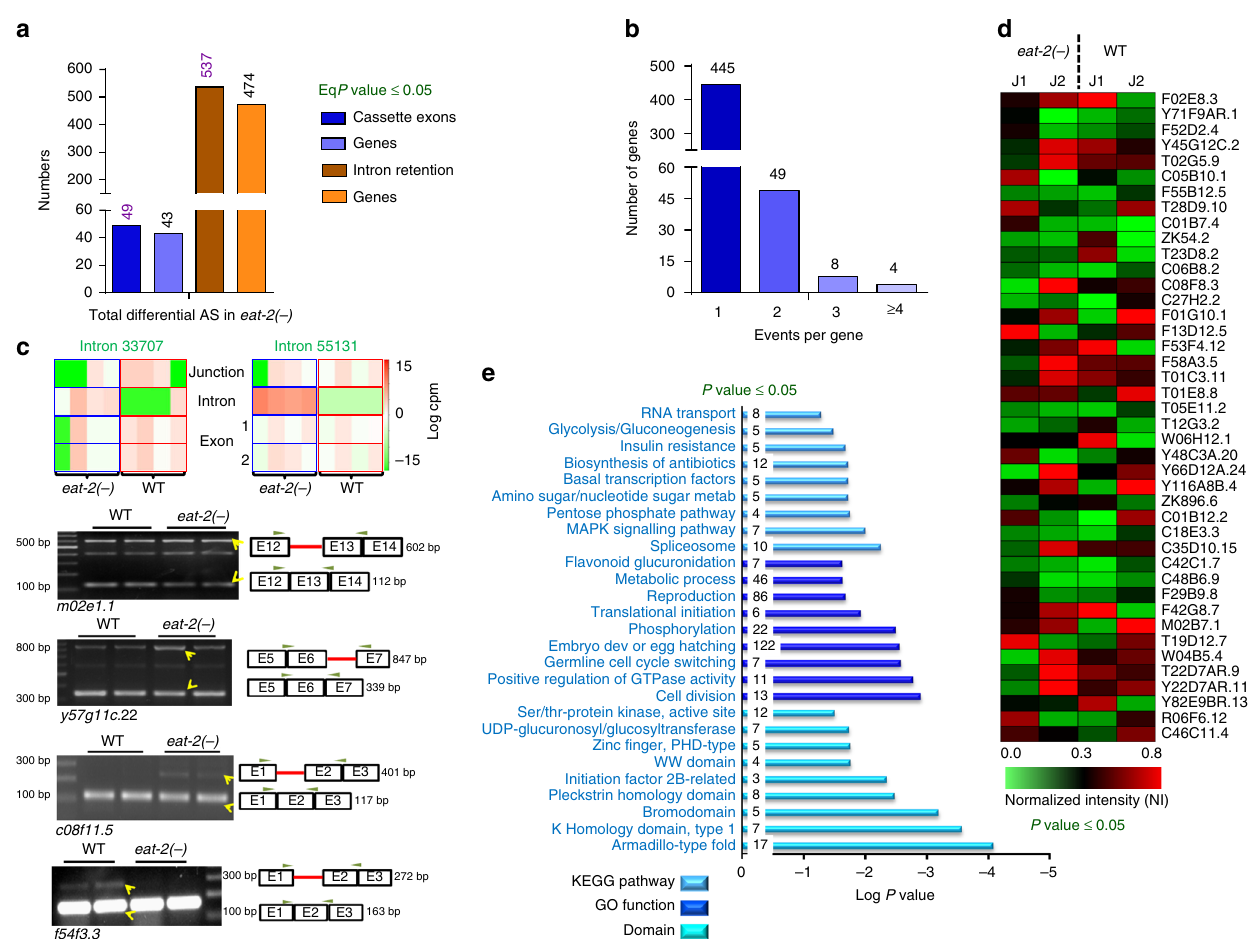
Fig. 1 Increased alternative splicing during DR in C. elegans . a AS events in day 3 eat-2(ad1116) (shown as eat-2(-) ) worms, as exhibited by the differential usage of cassette exons (CE; dark blue bars ) or by intron retention (IR; dark brown bars ). Total spliced-in and spliced-out events in eat-2(ad1116) are shown. The genes that these events correspond to are indicated in the lighter shades . Statistical test: Irwin – Hall P value summarization was used on each individual splicing event (details in the Methods section). Four biological replicates were used for analysis. b Distribution of the number of AS events per gene during DR. Both CE and IR events are considered together. c Upper panels showing representative images of AS involving intron retention. For this, two terms were considered, reads mapping to the introns and that of the skipping junction when the intron is not included, while ensuring that fl anking exons are expressed. Each blue or red box represents four biological replicates of the RNA-seq. In case of Introns 33707 and 55131, the read counts mapping to the intron or the junction were reciprocal in eat-2(ad1116) vs. WT. Lower panels : The above intron retention events belonging to m02e1.1 and y57g11c.22 are validated by RT-PCR. Two other AS events belonging to c08f11.5 and f54f3.3 are also validated below. In case of m02e1.1 , y57g11c.22 and c08f11.5 , the isoforms retaining the intron increase in eat-2(ad1116) , whereas the reverse happens in f54f3.3 . The two lanes for each sample are biological replicates. Yellow arrows indicate two alternatively spliced isoforms that show differential expression in WT and eat-2(ad1116) . Similar results were observed in at least three biological replicates. cpm counts per million. d Heat map depicting differential AS of top 42 genes in eat-2(ad1116) . J1 and J2 indicate two junctions of the same gene showing highest signi fi cant differences in their splicing indices. Statistical analysis was performed using two-tailed unpaired t- test with Sidak – Bonferroni correction for individual event. Data from four biological replicates. e KEGG pathway, Gene Ontology (GO) term enrichment and protein domains were determined by DAVID Functional Annotation tool using differentially AS genes. The numbers within the blue bars represent genes detected in the category. The listed pathways have a P value ≤ 0.05, Fisher Exact